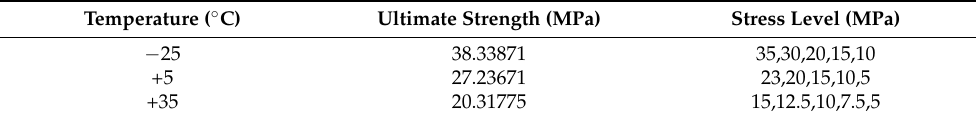
Table 1. Experimental scheme.